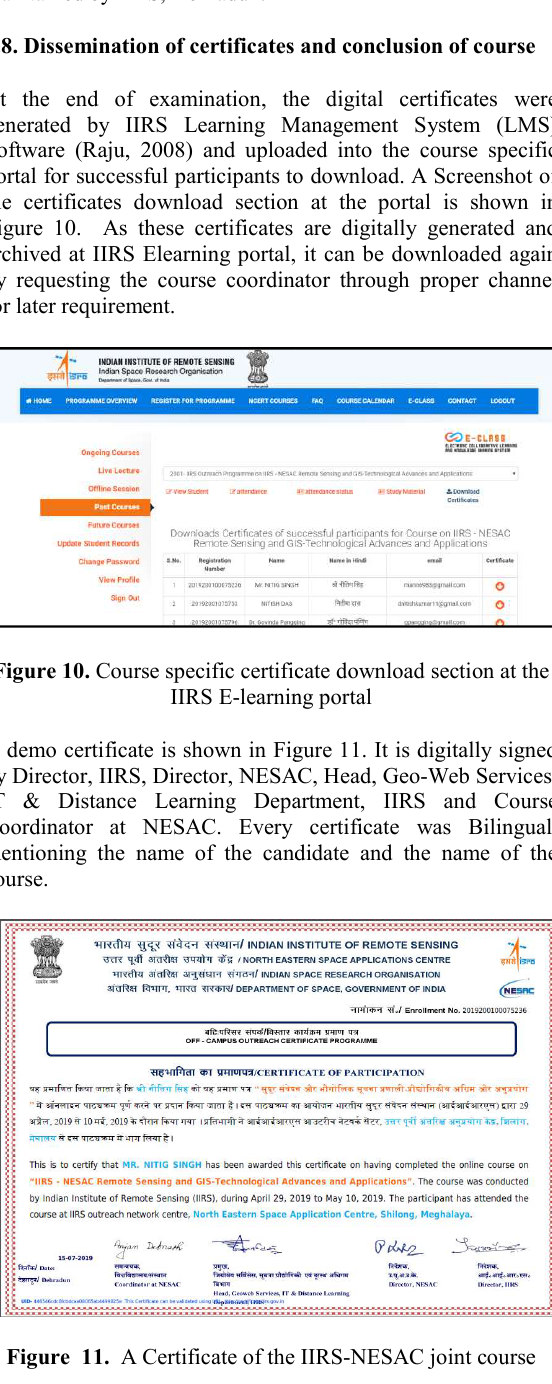
Figure 9. Screenshot of marks obtained by a candidate